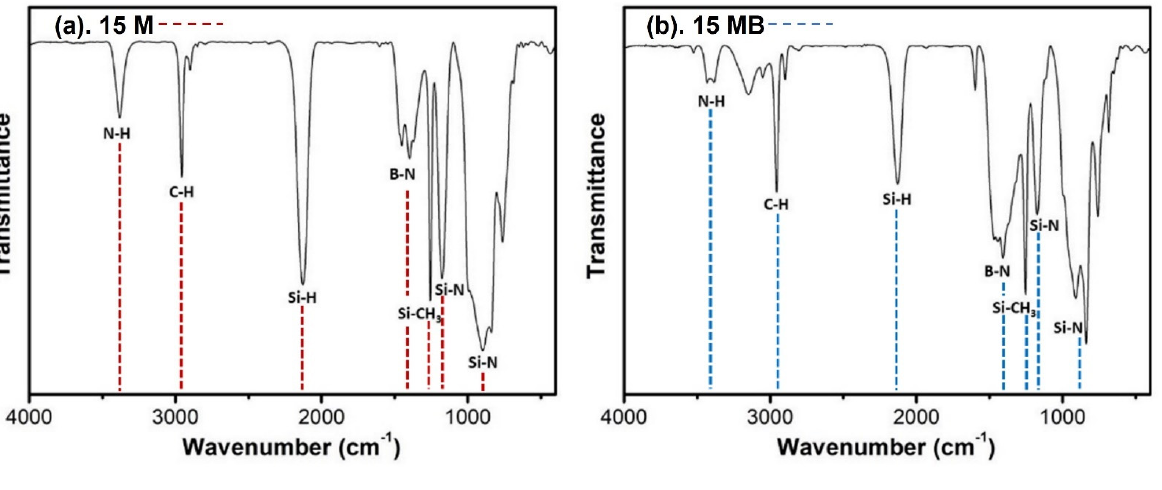
Figure 2. FTIR spectra of ( a ) 15 M and ( b ) 15 MB.